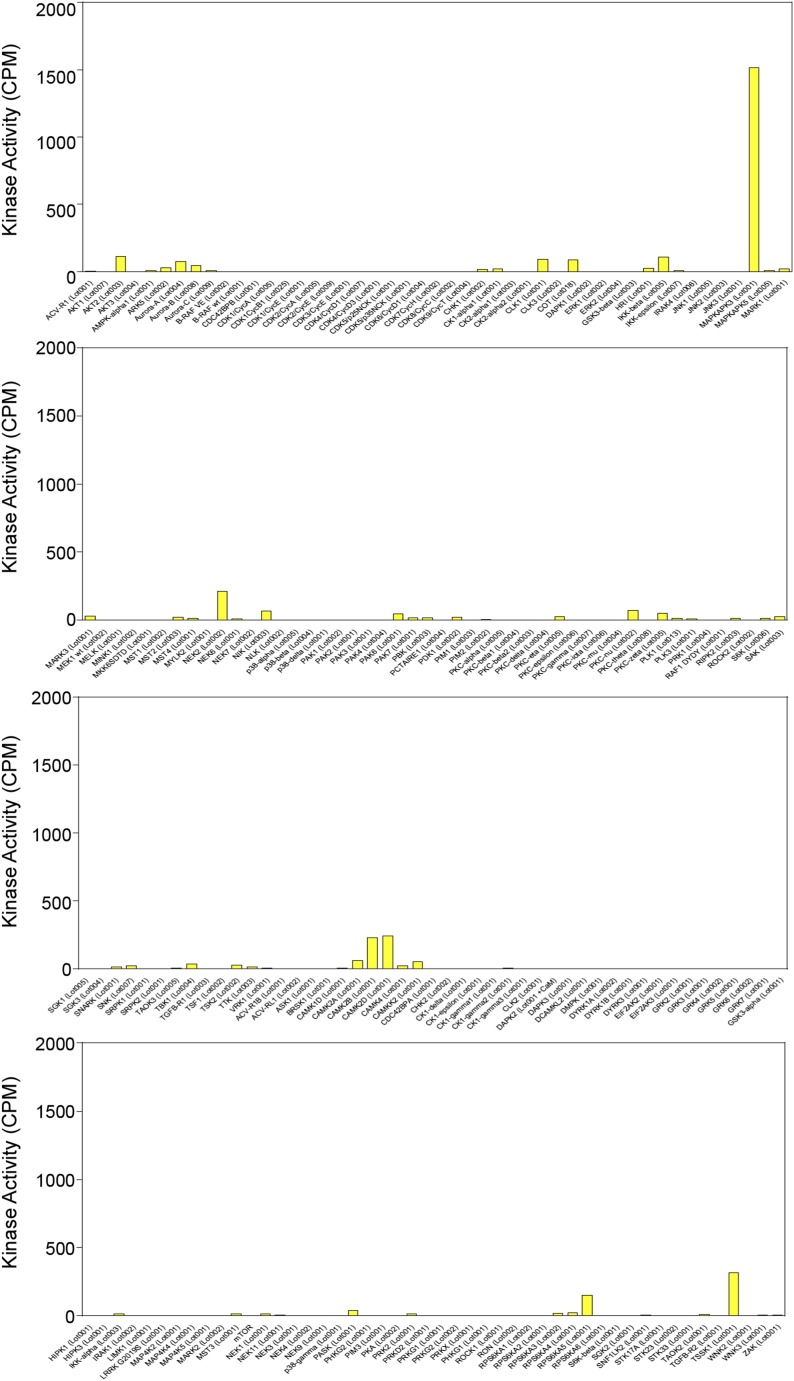
Results of in vitro kinase screen using the Beclin 1 83–97 peptide as a substrate.Kinases included in screen are listed in alphabetical order on the x-axis. See Supplementary file 1 for details.